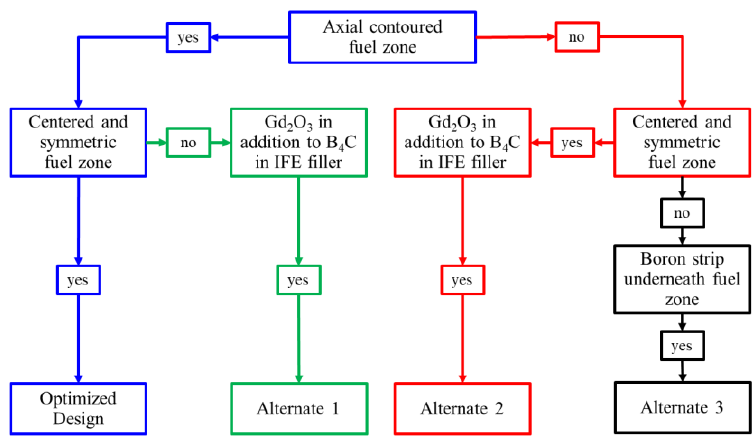
Figure 3. Conceptual design feature flowchart.